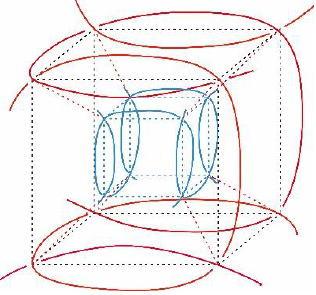
Figure 9. An example of knots with crossings located on a unit cell of the (3 + 1)D hypercubic Ising lattice. The black and blue dashed lines represent two cubes, while the red dashed lines connect vertexes of the two cubes, together representing a hypercube. The crossings corresponding to the vertexes in the black cube lattice are represented by red solid curves, while the crossings corresponding to the vertexes in the blue cube lattice are represented by blue solid curves. All the crossings form a “big” topological structure that is trivialized naturally.